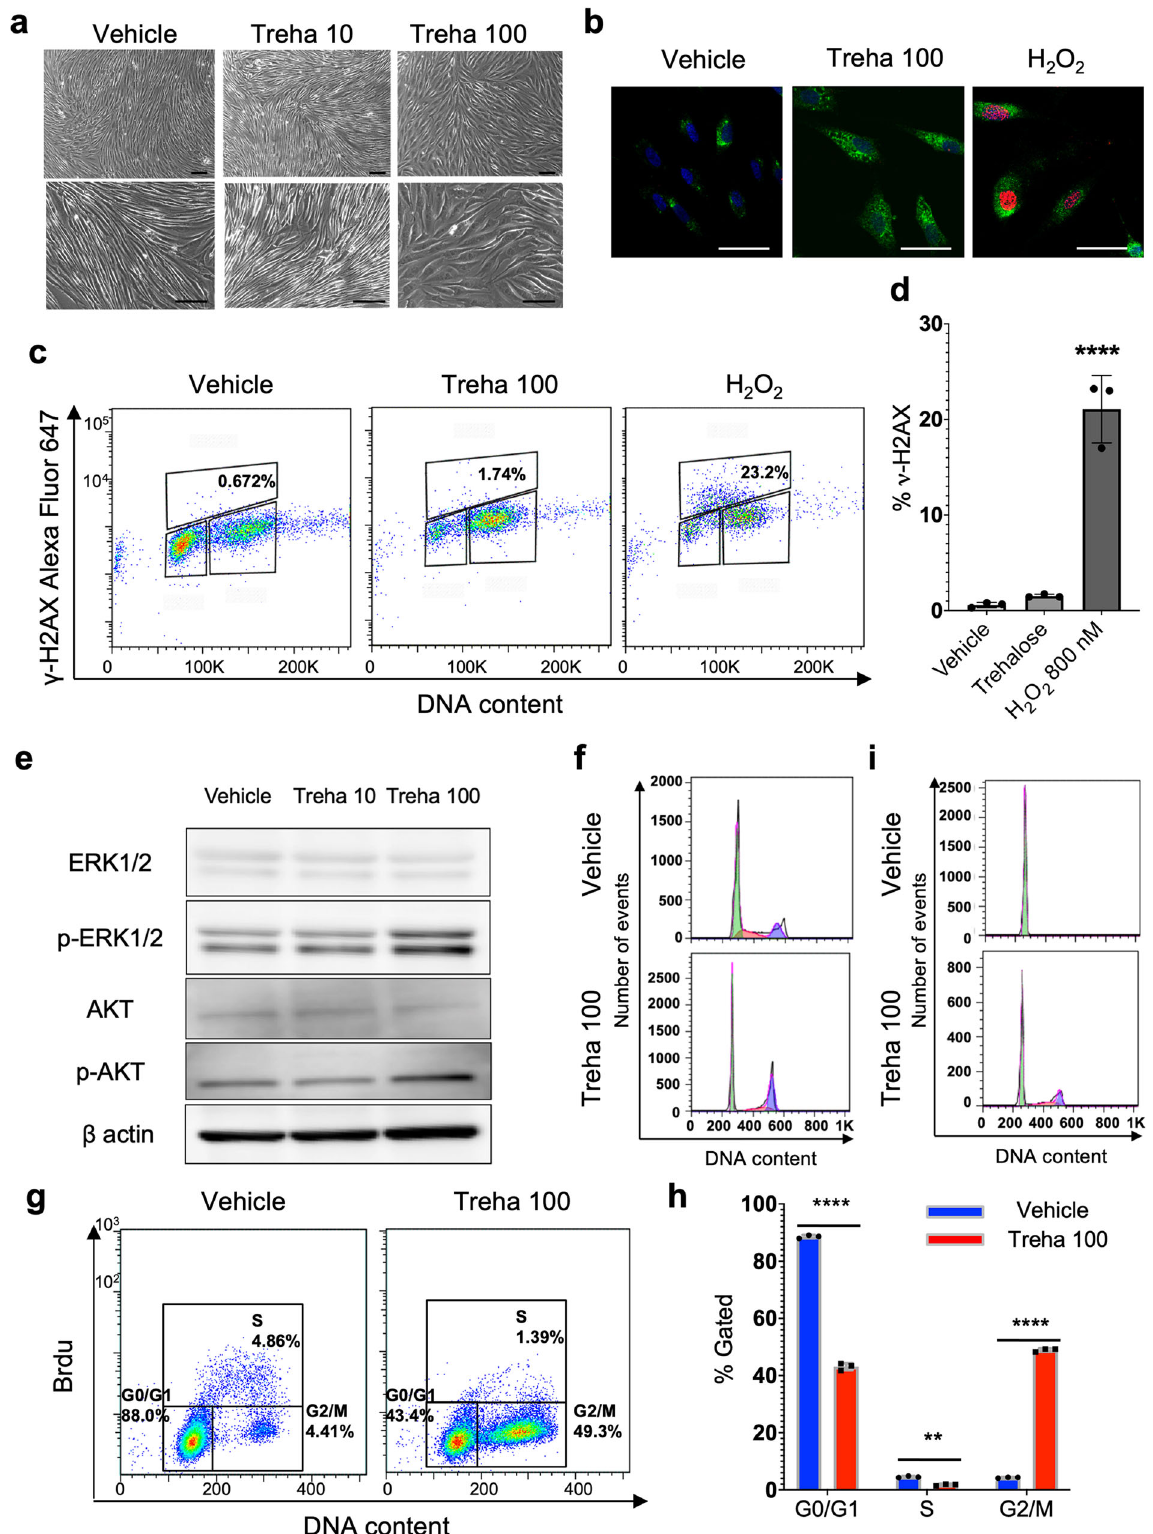
fi broblasts in 3D culture whereas vehicle treatment arrested them in the G1 phase after 1 week. Furthermore, signi fi cantly higher amounts of superoxide radicals were generated in trehalose- treated fi broblasts (Supplementary Fig. 9). Therefore, we conclude that trehalose triggers two antagonistic cell cycle regulatory pathways in fi broblasts: the classical mitogenic ERK and